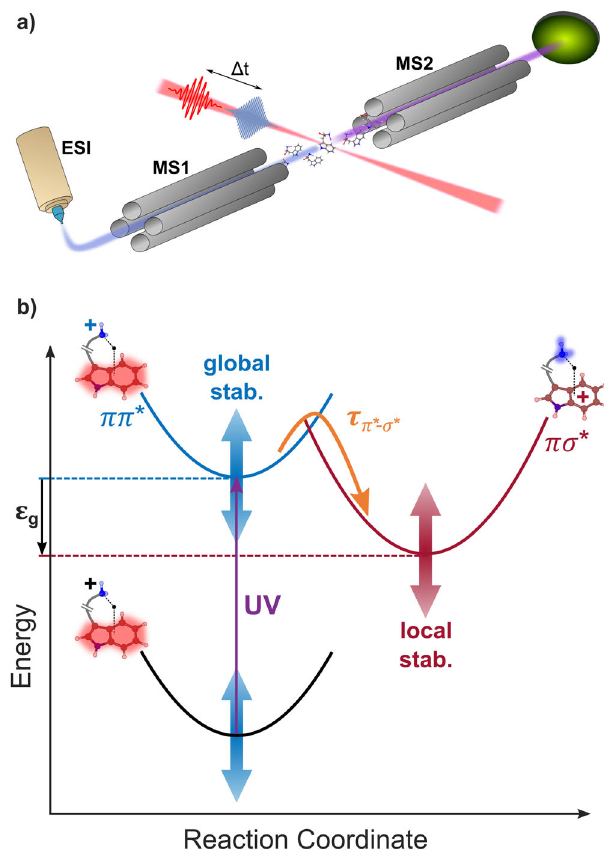
Fig. 1 Global and local stabilization effects in ππ * – πσ * dynamics of molecular ions. a Experimental setup for time-resolved spectroscopy of on- the- fl y molecular ions, combining an electrospray source (ESI), mass selection (MS1), laser interaction, and detection (MS2). b Concept of Global-Local Stabilization Separation (GLoSS), illustrated in the case of tryptophan-containing species: after absorption (in the UV range in this work), the relative energy gap ε g between the excited ππ * state (in blue, the red shading indicates the excited electron density) and the πσ * state (in red, the blue shading indicates the excited electron density) can be tuned to directly change the ππ * – πσ * transfer timescale. More precisely, the two states can be changed in energy by playing separately on the complexation interaction of the molecule with the adduct atom (global stabilization acting on the ground state) or on the speci fi c interaction of the adduct with the NH 2 moiety (local stabilization), thus changing their energy gap (in this fi gure, the πσ * state is represented as a bond state for sake of simplicity, while it corresponds to a dissociative